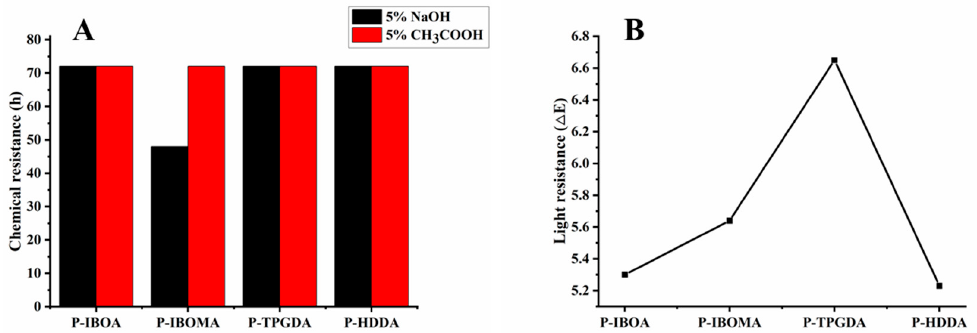
Figure 10. ( A ) Chemical resistance and ( B ) UV-light resistance of UV-cured PUA coating films.